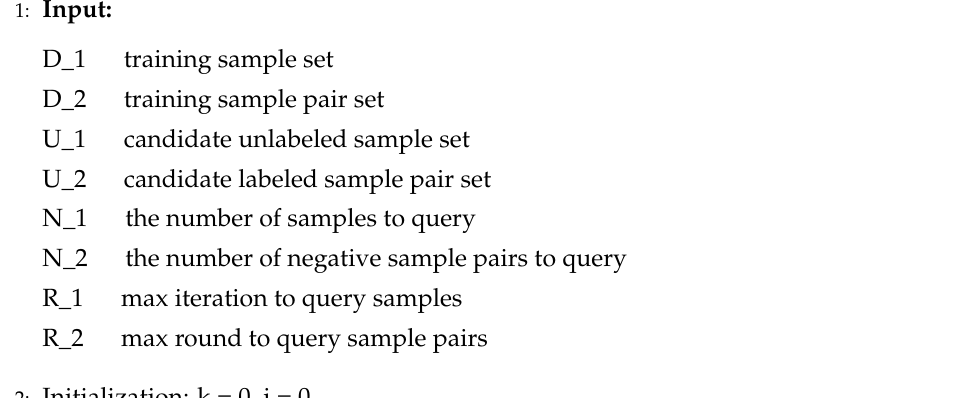
Algorithm 1 Active Learning-driven Siamese Network (ALSN) for Hyperspectral Im- age